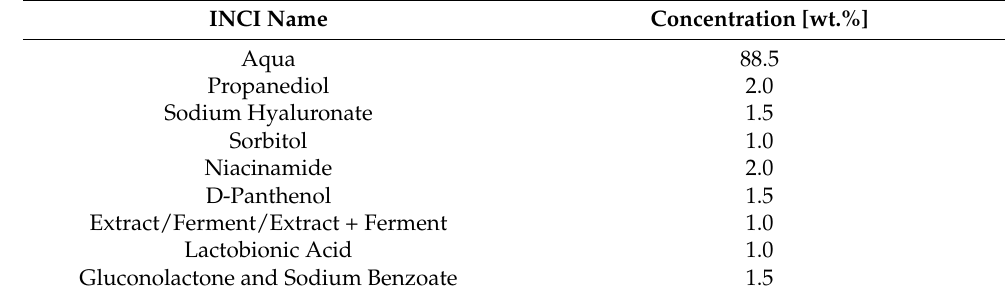
Table 5. Formulation of the analyzed model skin